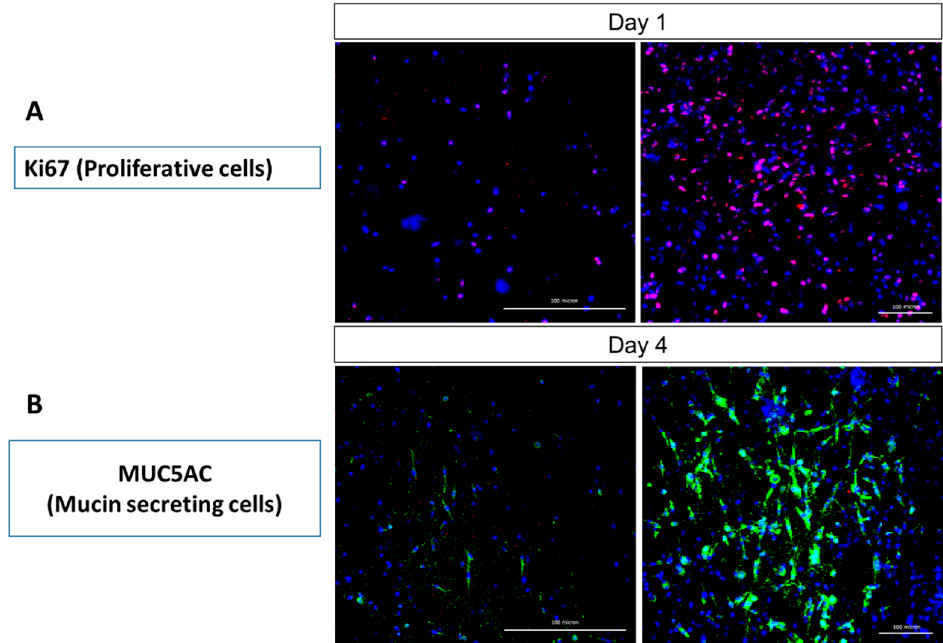
Figure 4. Immunohistochemistry of the human tissue respiratory epithelial construct (HTREC) with residing respiratory epithelial cells (RECs), immunostained with ( A ) anti-Ki67 antibody (red) as the proliferation marker and ( B ) anti-MUC5AC antibody (green) as the mucin secretion marker. The cell nuclei were counter-stained with 4`,6-diamidino-2-phenylindole (DAPI) (blue). The RECs were found to be proliferating ( A ) and secreting mucin ( B ) while residing within the CaCl 2 -polymerized human plasma. The scale bar represents 100 μ m. The results are representative of three biologically independent experiments.